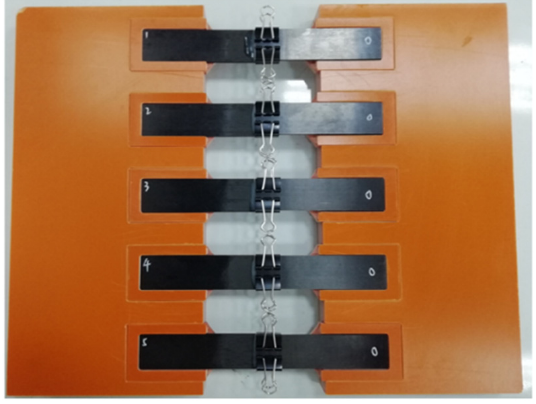
Figure 3. The fabricated single-lap specimen.